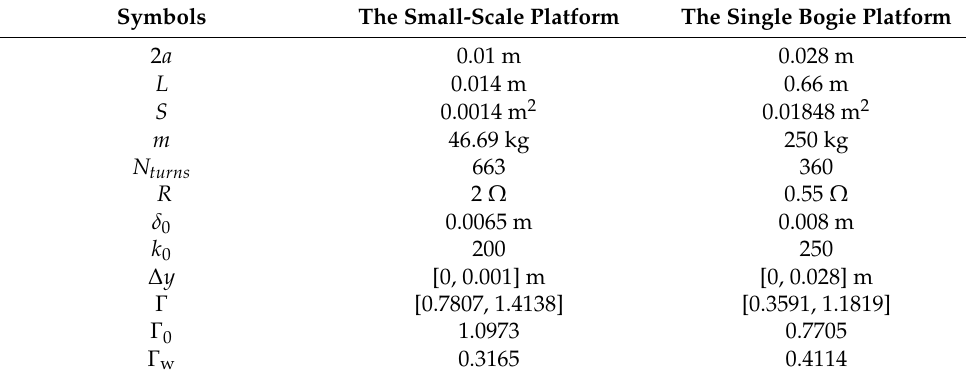
Figure 15. The single-bogie experimental platform of the suspension system. Table 2. Relevant parameters of the suspension system. Symbols The Small-Scale Platform